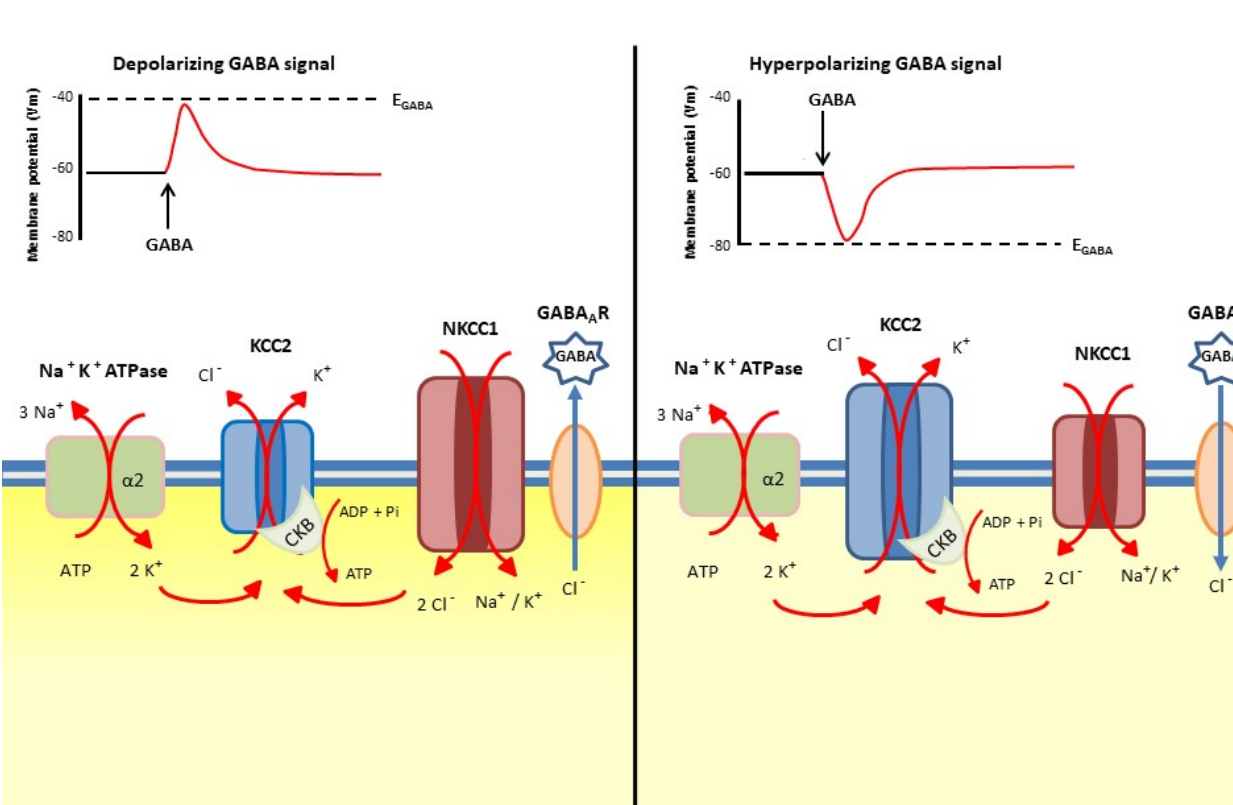
Figure 1. The main cation-coupled chloride co-transporters which mediate [Cl − ] i developmental shift. Left side: in immature neurons [Cl − ] i is higher than in mature ones (right side). The intensity of the cytoplasm color refers to the intracellular chloride concentration. KCC2, K + -Cl − co-transporter 2; NKCC1, Na + , K + -2Cl − co-transporter 1; CKB, brain-type creatine kinase; Na + , K + -ATPase, sodium-potassium pump. The α 2 subunit of Na ⁺ /K ⁺ -ATPase couples potassium entry into the cell with the K-Cl coordinated efflux from the cell. The size of the symbols depicting KCC2 and NKCC1 is reminiscent of the change of the co-transporter amount and activity in the developmental shift.